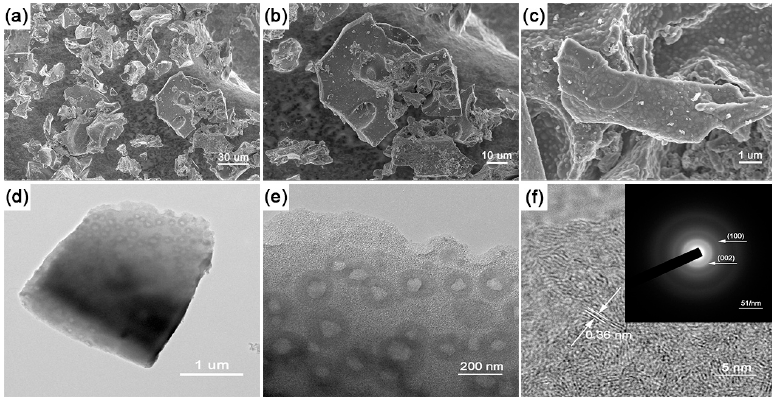
Figure 1. Scanning electron microscopy (SEM) images of thin boron carbonitrides (BCN) sheets ( a – c ); transmission electron microscopy (TEM) image ( d – e ); and, high-resolution transmission electron microscopy (HRTEM) ( f ) image with selected area electron diffraction (SEAD) pattern (inset) of thin BCN sheets.